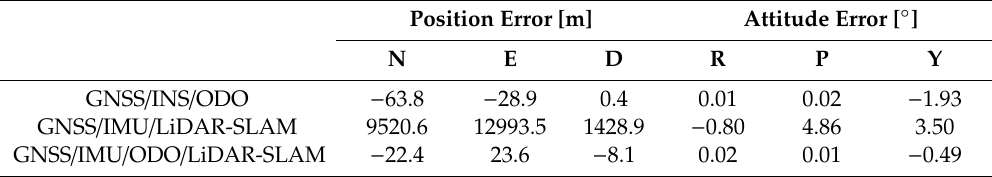
Figure 13. GNSS/IMU/ODO/LiDAR-SLAM navigation errors in the East Lake Tunnel test. Figure 13. GNSS / IMU / ODO / LiDAR-SLAM navigation errors in the East Lake Tunnel test. Table 3. The navigation errors in the end of the